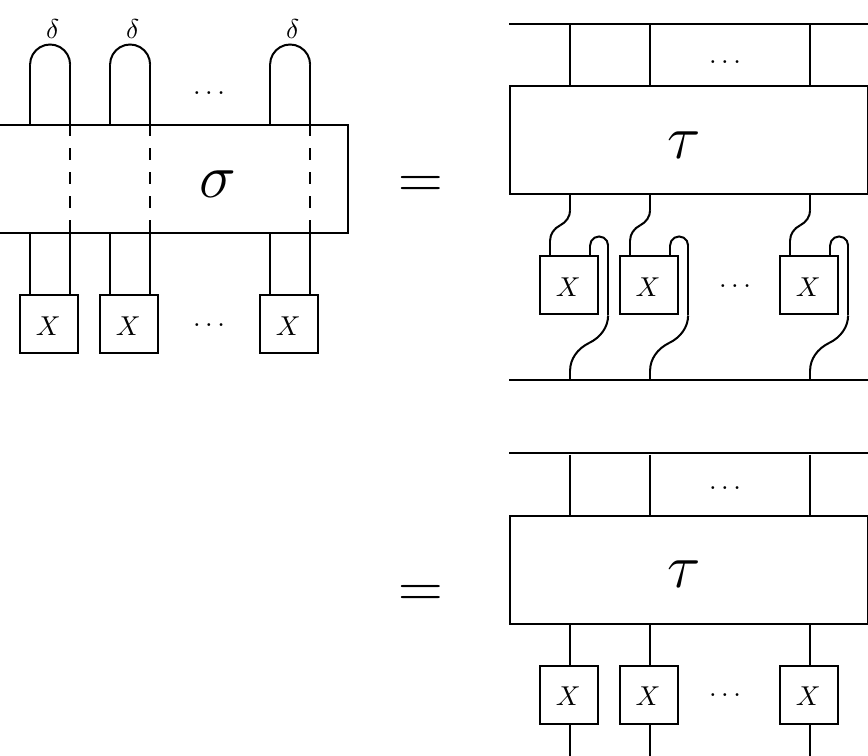
Figure 5 . A diagrammatic version of (4.12). The dotted lines represent the fact that (cid:27) (cid:12)xes all even numbers. The (cid:12)rst row keeps the index positions in X constant, while the second b+reaks our index conventions and uses the index structure X i = X ij to illustrate that using (cid:27) 2 S (odd) j